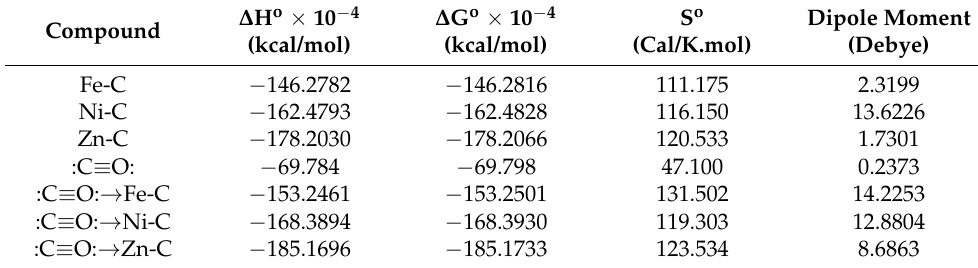
Table 3. The physico-chemical properties of CO adsorbed on Fe-, Ni-, and Zn-doped graphene nanosheets as selective gas